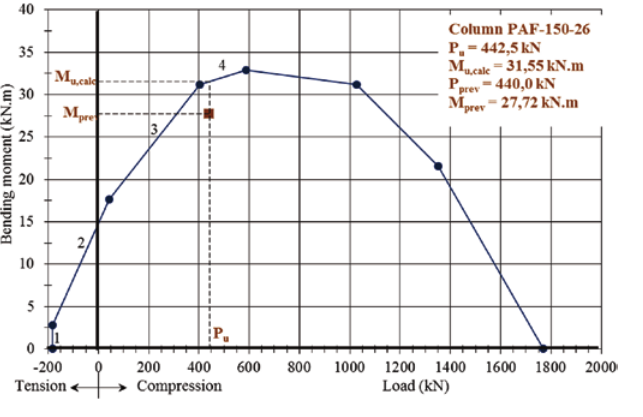
Figure 16 N-M Interaction diagram for column